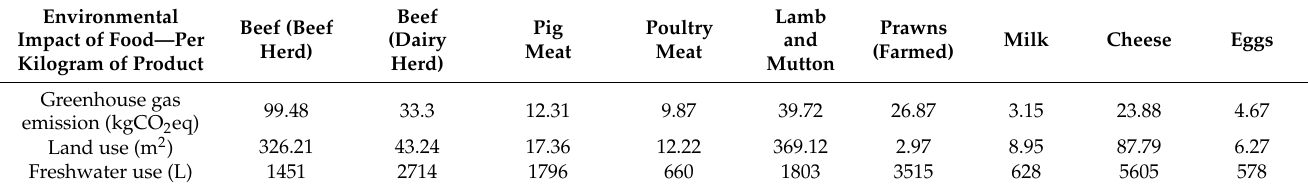
Table 4. Environmental impact of animal farming—authors’ selection after [50].